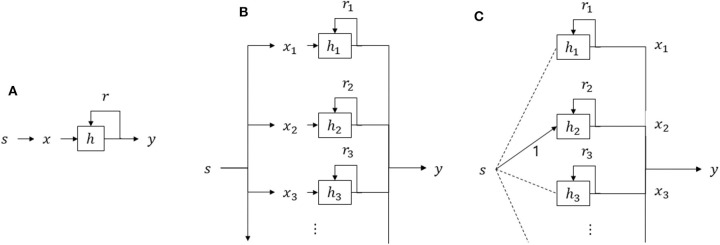
Block diagrams of the discounting models. (A) Depicts the simple discounting model. The model transforms the stimulus into the moment utility x and the moment utility is then added to the discounting node h, which has negative feedback (discounting) r to generate total utility y. (B,C) Show two ways of depicting the preference-dependent discounting model. Compared to (A), the PD model has multiple nodes in (B) to produce different discounting effects for different preference levels. In the equivalent diagram (C), the need for stimulus classification by their preference is removed and the preference can be defined as a summation weight at the last layer, as a result of the variety in weights of multiple nodes, described in more detail in the text.